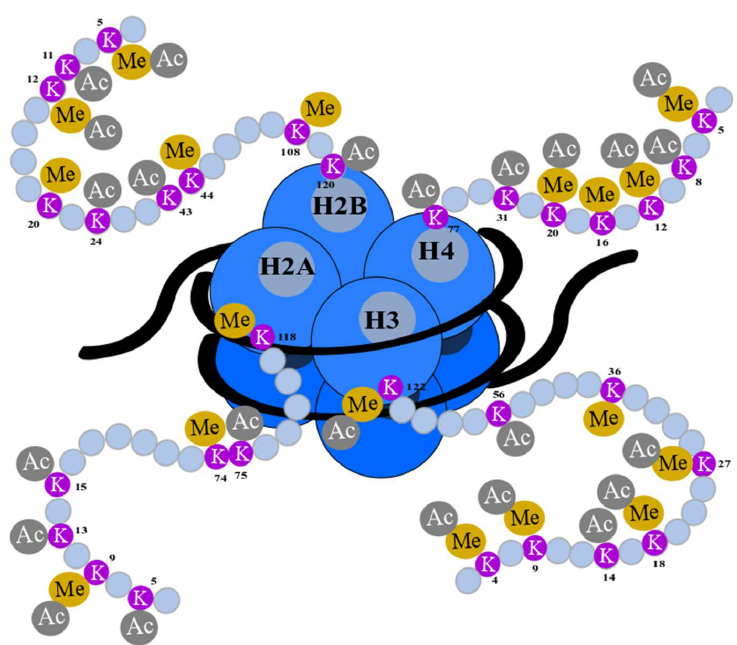
Figure 4. Epigenetic modifications of a histone N-terminus. Lysine (K) residues are located at the N-terminal (gray) of histones: H2A, H2B, H3, and H4 (blue) and encircled DNA (black). They